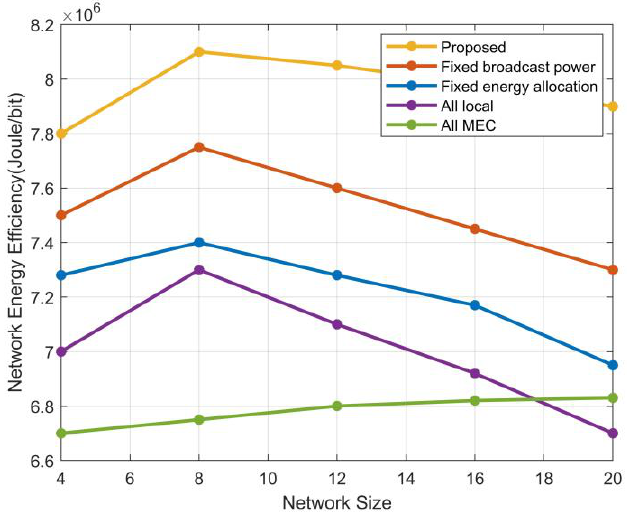
Figure 3. The performance of energy efficiency under different algorithms with network size.